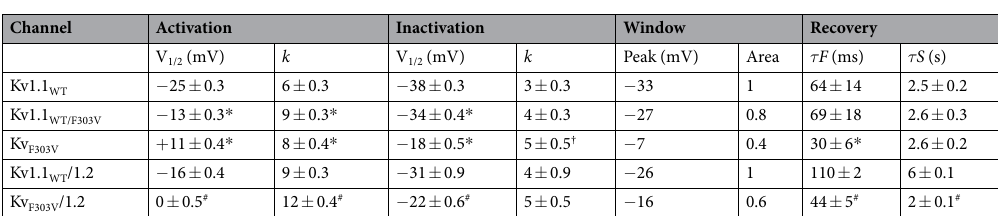
Table 1. Biophysical parameters. V 1/2 and k represent voltage for half-maximal activation and slope factor determined from Boltzmann fits; mean ± SE. n = 6 for each channel group. * ,† Significantly different